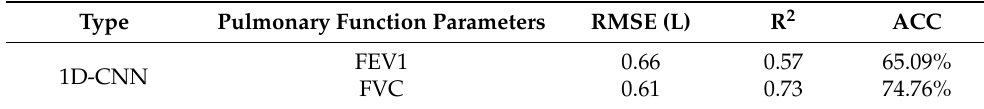
Table 5. Results of the deep learning algorithm.